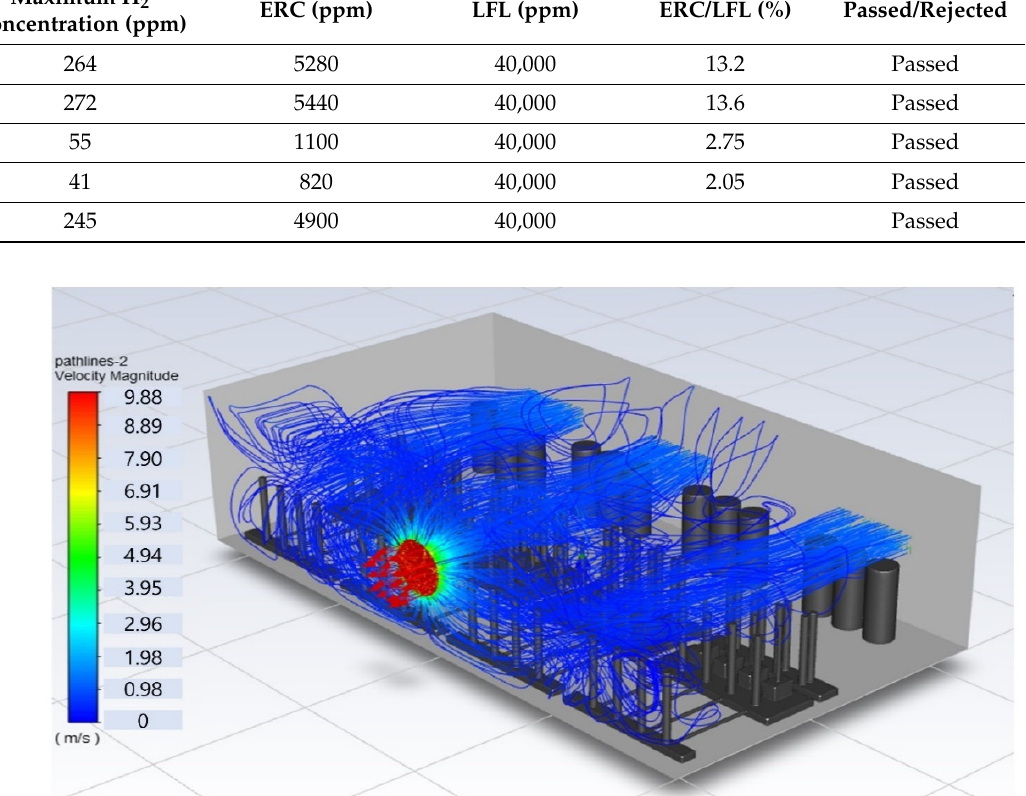
Figure 6. Distribution of streamlines from air inlet in the gas box.